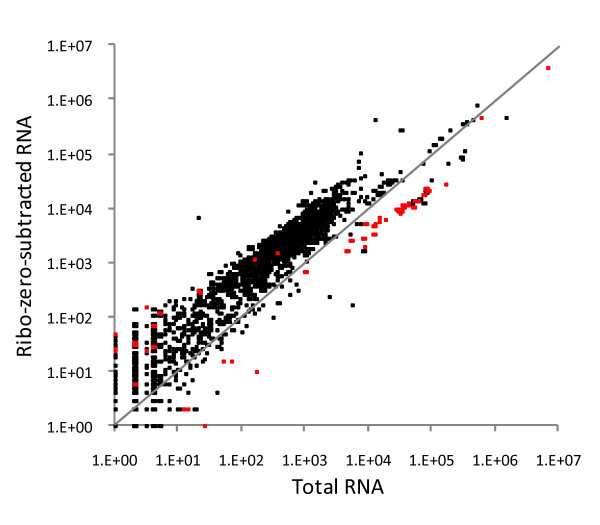
Comparison of total RNA and Ribo-Zero-subtracted RNA from Drosophila ananassae. The reads from both samples were mapped with BWA against the D. ananassae scaffolds. Each scaffold was then computationally divided into 100 kbp fragments and the number of reads mapping to the fragment were counted. When scaffolds were <100 kbp, the entire scaffold was counted. The last fragment of each scaffold was always <100 kbp. Fragments containing annotated rRNA are shifted right of the diagonal (gray line) due to decreased representation in the Ribo-Zero-treated RNA. Meanwhile, fragments without rRNA are shifted leftward of the diagonal (gray line) because of their increased abundance relative to the entire sequenced population in the subtracted samples.